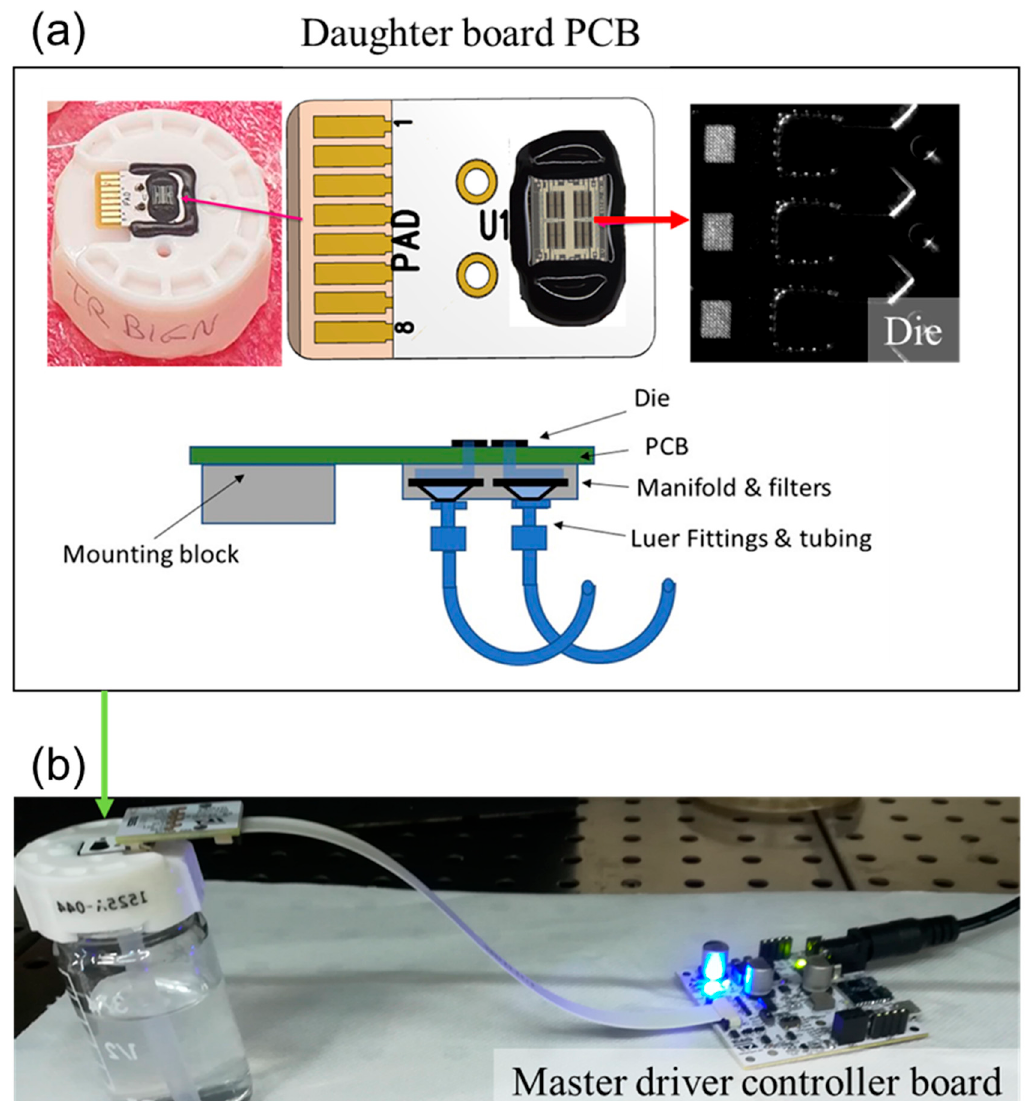
Figure 2. Structure of the Printed Circuit Board (PCB) with microscopic magnification of the die (red arrow) attached on one side of the PCB ( a ); the system set-up assembled and composed by the daughter board PCB and the master driver controller board with power cable ( b ).